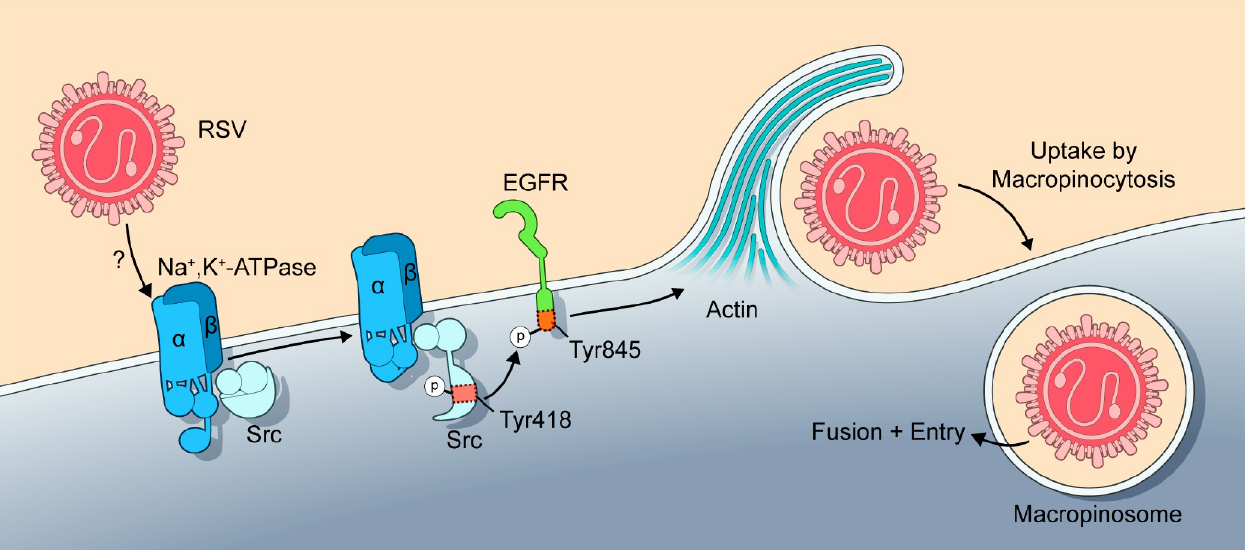
Fig 13. Proposed model of ATP1A1-dependent macropinocytic entry of RSV. On exposure to respiratory epithelial cells, RSV triggers the activation and clustering of ATP1A1 in the plasma membrane through an unknown mechanism. ATP1A1 then signals via phosphorylated Src-kinase and transactivates EGFR by its phosphorylation at Tyr845. Upon activation, EGFR signaling causes cytoskeletal rearrangement resulting in plasma membrane ruffling and formation of membrane extensions (reported previously [31, 33, 34]) that engulf fluid and RSV into macropinosomes. Note that RSV is taken up into the macropinosome in its enveloped state suggesting that it does not fuse at the cell surface; fusion and release of the nucleocapsid likely occurs within the internalized macropinosome.